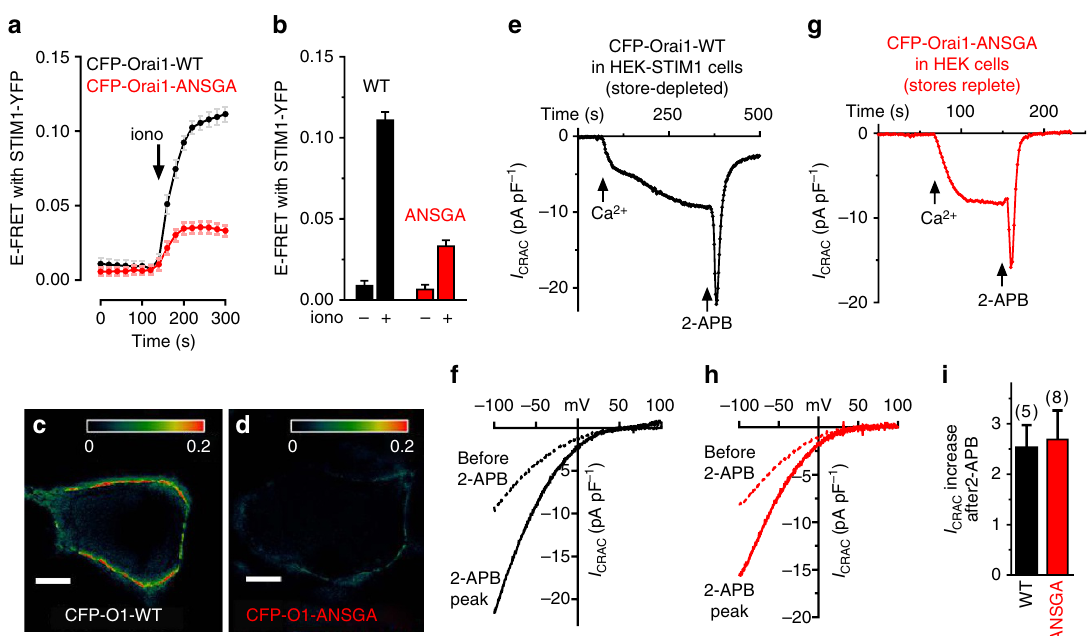
Figure 3 | The Orai1-ANSGA mutant has modified STIM1 binding but is pharmacologically identical to the STIM1-activated Orai1-WT. ( a ) E-FRET changes in HEK-STIM1-YFP cells transiently expressing CFP-Orai1-WT (black) or CFP-Orai1-ANSGA (red) following ER Ca 2 þ store depletion with ionomycin (2.5 m M). ( b ) Summary of E-FRET values for the Orai1 mutants-WTand mutant before and after store depletion. Calculated FRET image from CFP-Orai1-WT ( c ) and CFP-Orai1-ANSGA ( d ) 3min after ionomycin. Scale bar, 5 m m. ( e , f ) Using internal BAPTA-dialysed HEK-STIM1-YFP cells expressing CFP-Orai1-WT, I CRAC was observed on 20mM external Ca 2 þ addition. A unit of 50 m M 2-APB induced rapid transient I CRAC activation ( I – V curves shown were 8s before 2-APB, and at the peak following 2-APB addition). ( g , h ) In store-replete HEK cells expressing CFP-Orai1-ANSGA, constitutive I CRAC was measured on external Ca 2 þ addition, and 50 m M 2-APB added as in e giving identical, rapid transient activation of I CRAC , as revealed from I – V curves 8s before 2-APB, and at the peak following 2-APB addition. ( i ) Summary of 2-APB induced increase in I CRAC from individual cells. All values are means ±